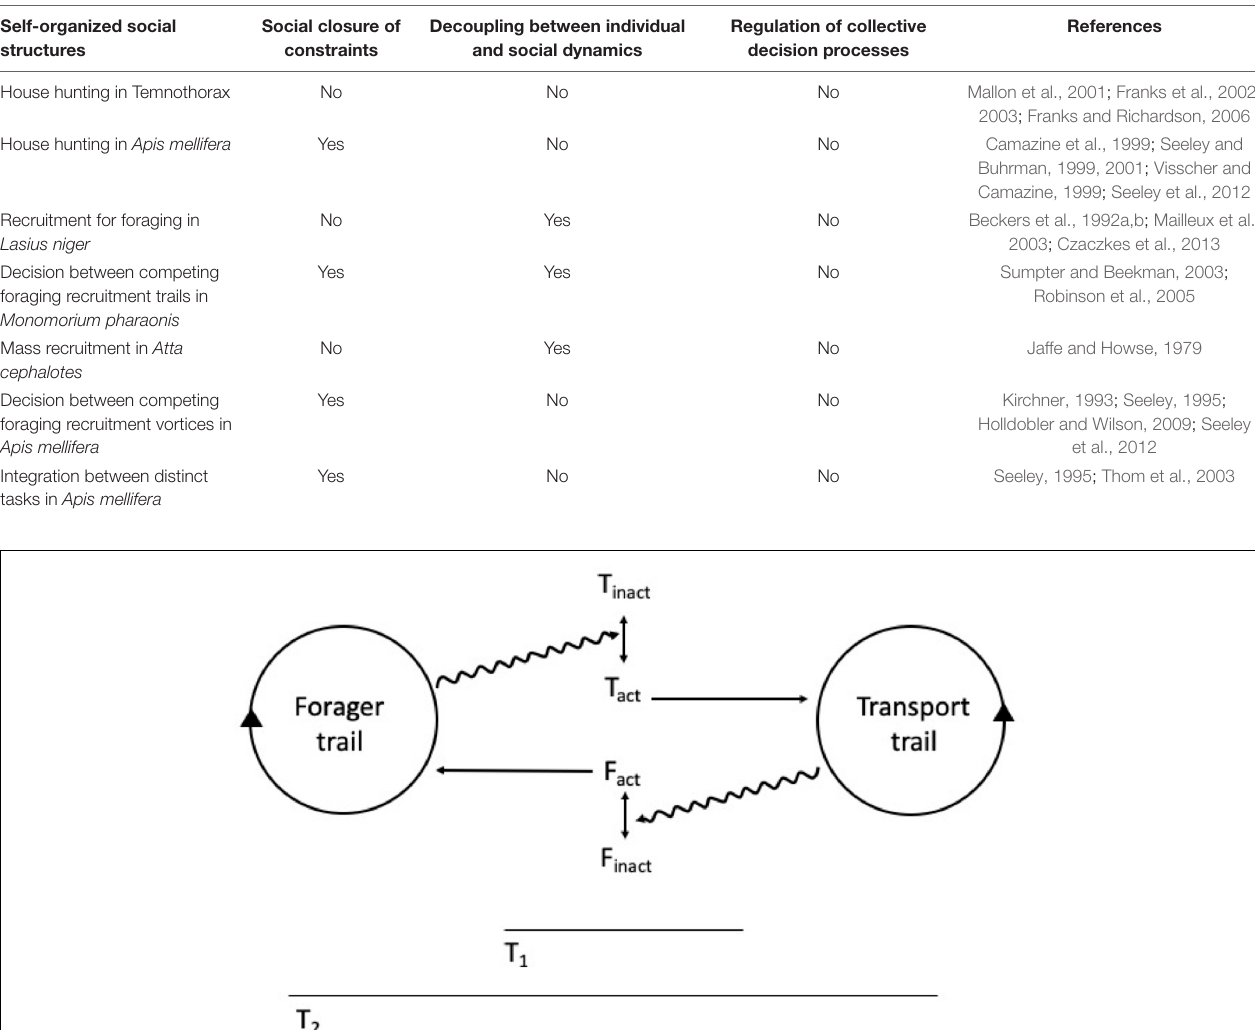
TABLE 1 | Fulfillment of the organizational requirements for the ascription of social personality in particular cases of self-organized social processes. Self-organized social structures